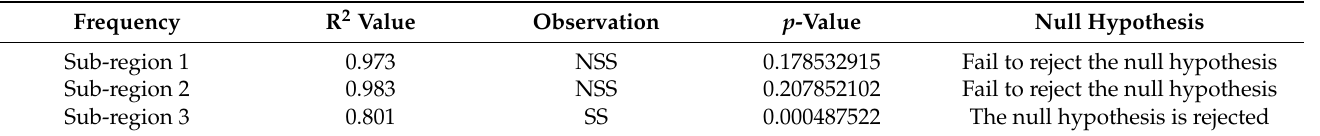
Table 12. Case study 3 ANOVA results.